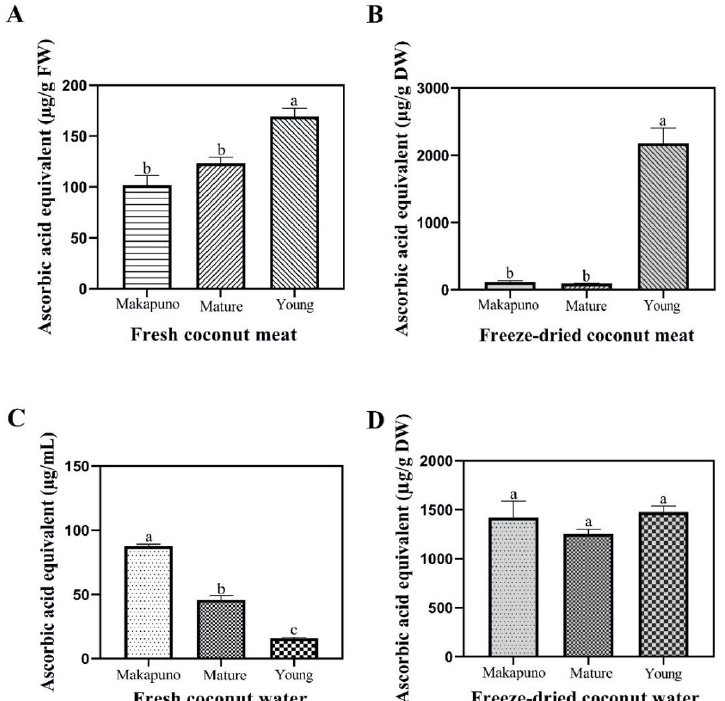
Figure 7. Ferric-reducing antioxidant power assay. FRAP assay of coconut meats in fresh ( A ) and freeze-dried ( B ) samples. FRAP assay of coconut water and Makapuno water in fresh ( C ) and freeze- dried ( D ) samples. All experiments were performed in triplicate. Data are expressed as mean ± SE (n = 3, p < 0.05) for all tested. Different letters indicate mean values significantly different. Through the analysis of scavenging activity of ABTS radical in coconut samples, we observed similar trends as in the DPPH assay. Young coconut meat displayed the highest antioxidant activity (45%), followed by 25% and 20% in the extracts from Makapuno and mature coconut meat, respectively (Figure 8A). The freeze-dried meat samples showed no significant difference in the ABTS scavenging activity in all samples analyzed (Figure 8B).